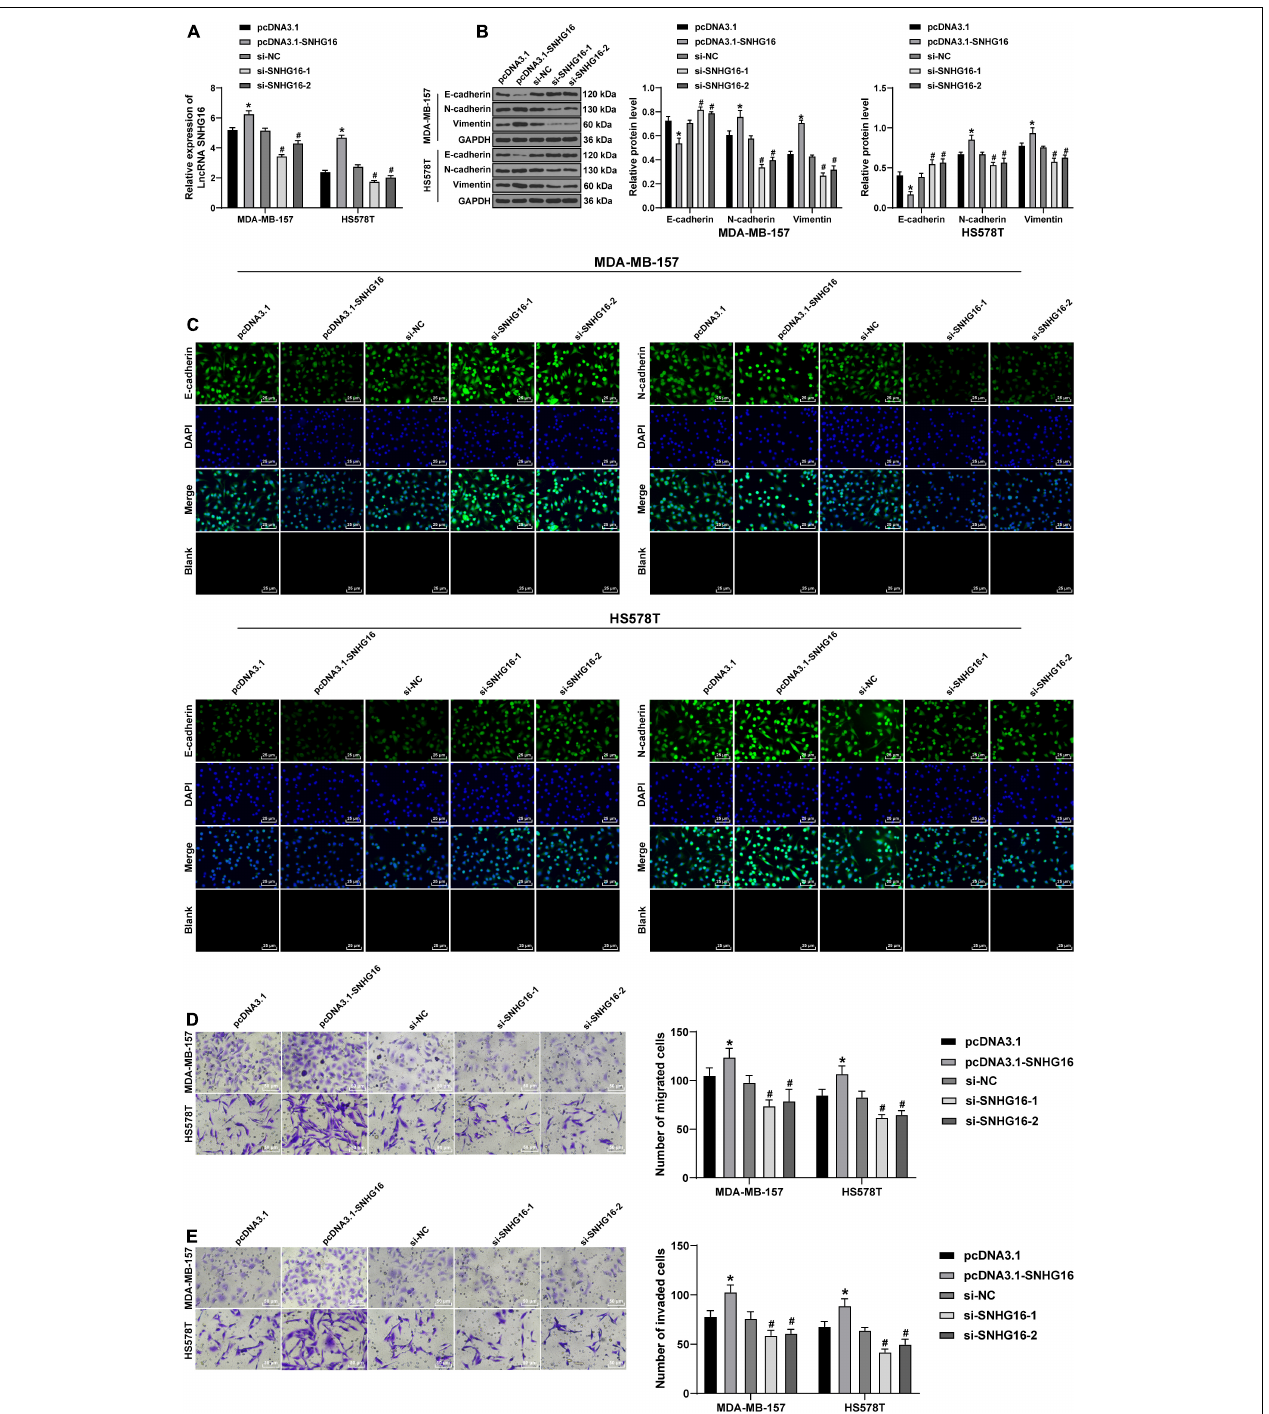
FIGURE 2 | Overexpression of SNHG16 promoted migration and invasion of BC cells. MDA-MB-157 and HS578T cells were transfected with si-SNHG16-1, si-SNHG16-2, si-NC, pcDNA3.1, and pcDNA3.1-SNHG16. (A) The expression of SNHG16 was detected using RT-qPCR to verify the transfection efficiency. (B) The levels of E-cadherin, N-cadherin, and vimentin were detected using Western blotting. (C) The levels of E-cadherin and N-cadherin were detected using immunofluorescence ( × 200). (D,E) The migration and invasion abilities of cells were measured to evaluate the effect of different expressions of SNHG16 on the metastatic ability of BC cells. Cell experiment was repeated three times. Data were presented as mean ± standard deviation. Data in A, D, and E were analyzed using two-way ANOVA, and data in B were analyzed using one-way ANOVA, followed by Tukey’s multiple comparison test, * p < 0.05 vs. pcDNA3.1 group, # p < 0.05 vs. si-NC